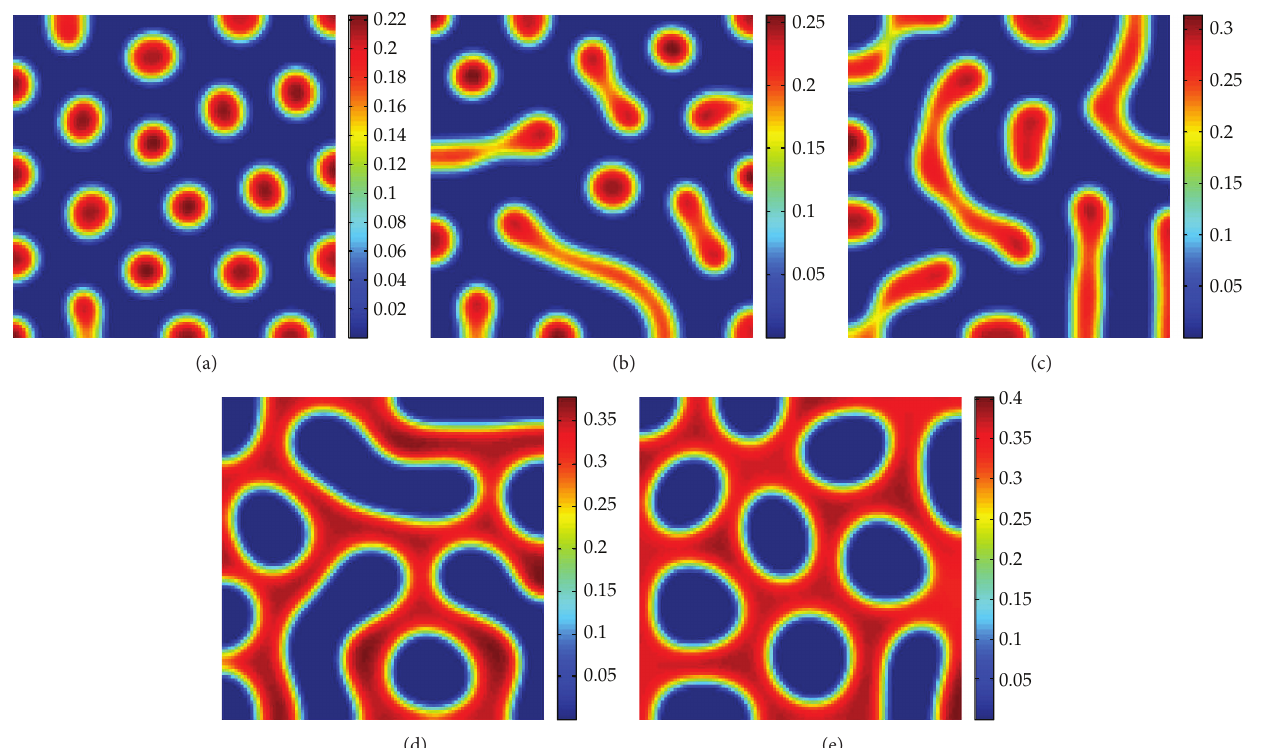
Figure 1: Five typical Turing’s patterns of 𝑢 in model (3) with fixed parameters 𝑏 = 9 , 𝑐 = 0.5 , 𝑑 = 0.45 , 𝑑 11 = 0.01 , 𝑑 22 = 1 , 𝑑 12 = −0.025 , and = 0.01 . (a) Spots pattern, 𝑚 = 0.05 ; (b) spot-stripe mixtures pattern, 𝑚 = 0.125 ; (c) stripes pattern, 𝑚 = 0.25 ; (d) hole-stripe mixtures, 𝑑 21 𝑚 = 0.45 ; (e) holes pattern, 𝑚 = 0.5 . Iterations: pattern (a): 5 × 10 5 , pattern (c): 1 × 10 5 , and others: 3 × 10 5